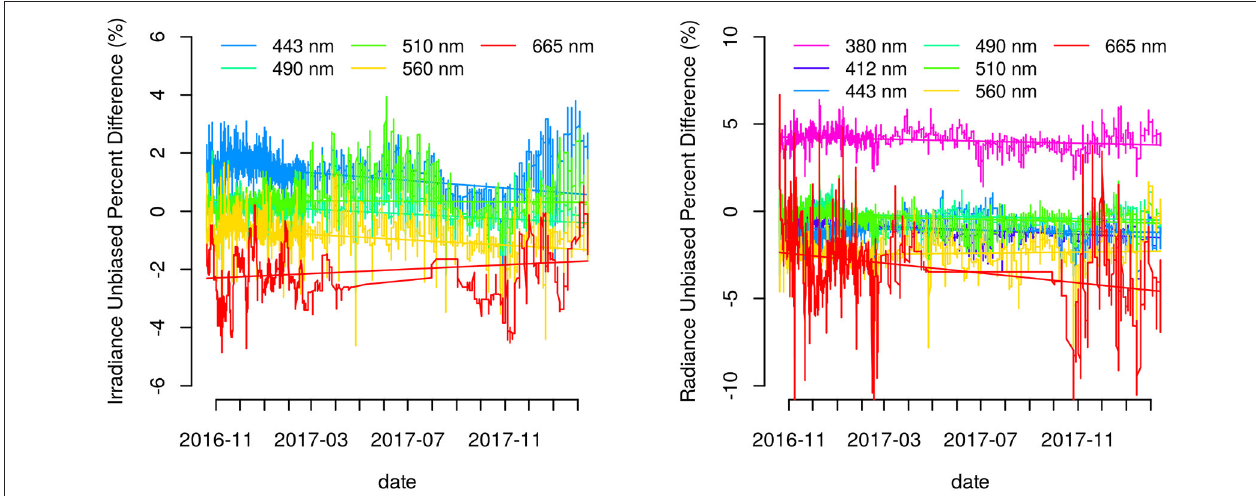
FIGURE 7 | Running median of the Unbiased Percent Difference for Irradiance (left) and Radiance (Right) for the lovapm011b float over 480 days and 247 profiles. The float profiling cycle was daily at the beginning, then every three days starting in early 3/2017. Linear trends are shown.